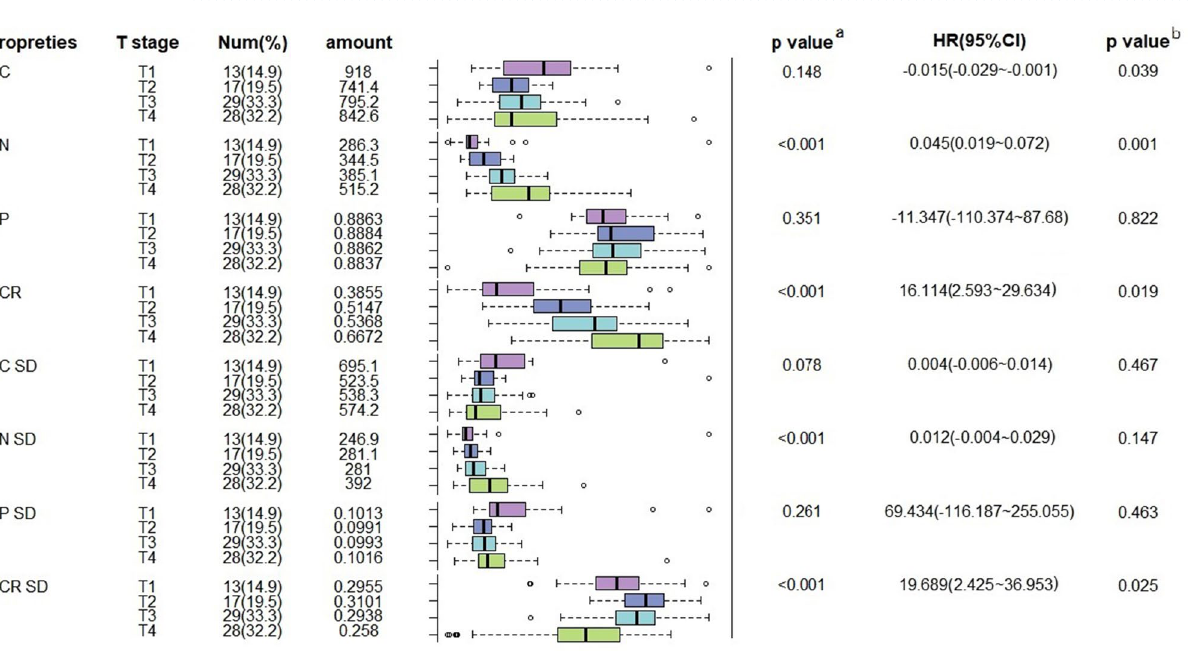
Figure 2. Comparison of cell properties. Each cell in each WSI was analyzed to determine the inherent properties of the signet ring cells in the case. ( A ) digital slices obtained by scanner ( B ) highlights the signet ring cells in heatmap ( C ) the distribution of cell number and cross-sectional area was shown on the histogram ( D ) the boxplot shows the comparison of inherent properties of all cases (Independent sample t test).